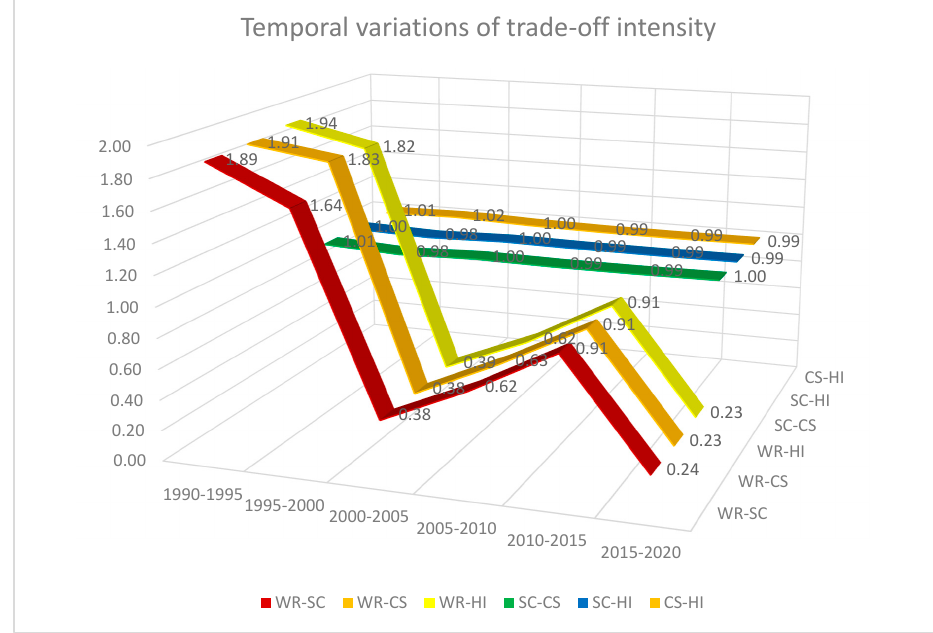
Figure 6. Trade-off intensity for six pairs of ecosystem services in six periods.